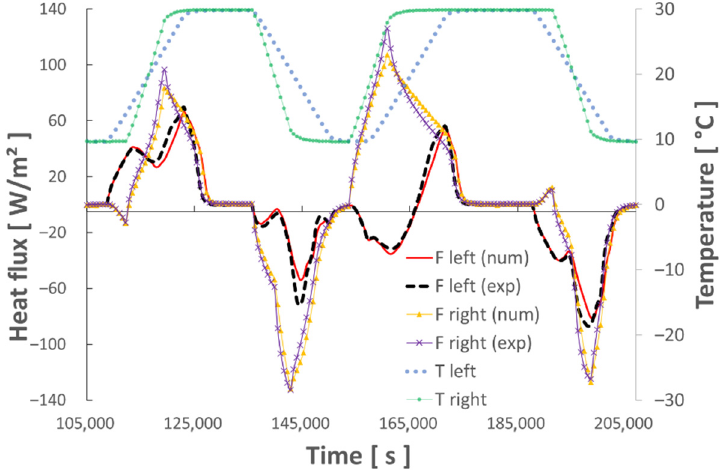
Figure 16. Evolution of the flux exchanged between the plate and the sample (asymmetric ramp).